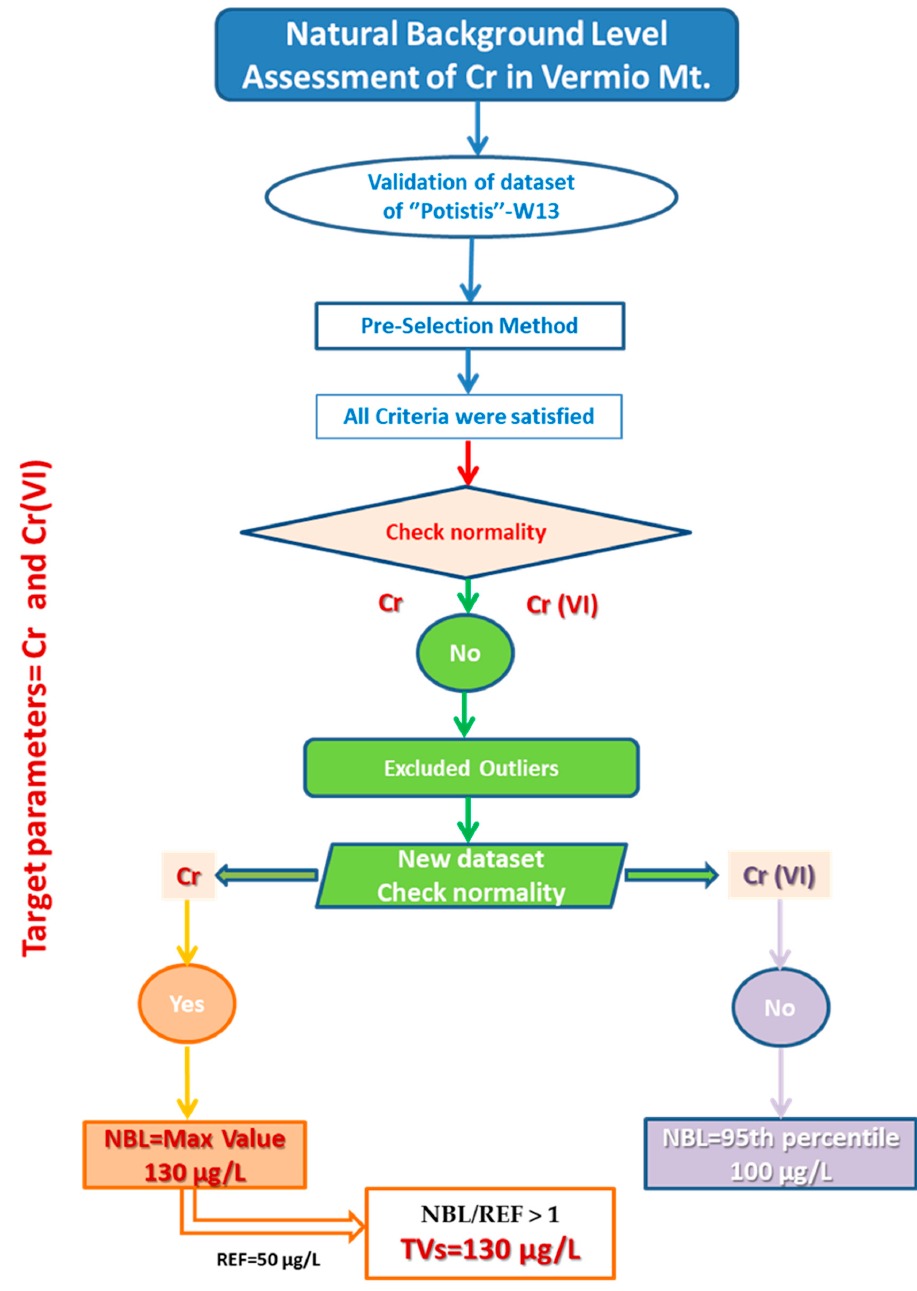
Figure 22. Flow chart of the modified conceptual model for assessing NBLs and TVs of Cr and Cr(VI) of the natural spring “ Potistis” ‒ W13, in western Vermio Mt.